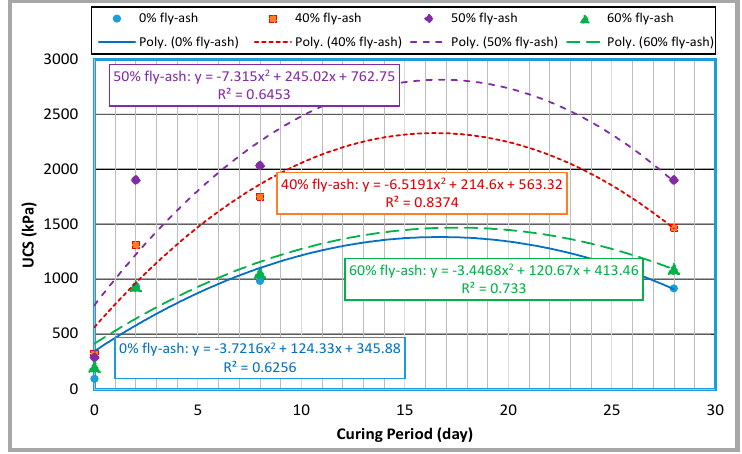
Figure 7. Variation of UCS with curing period with trend lines.